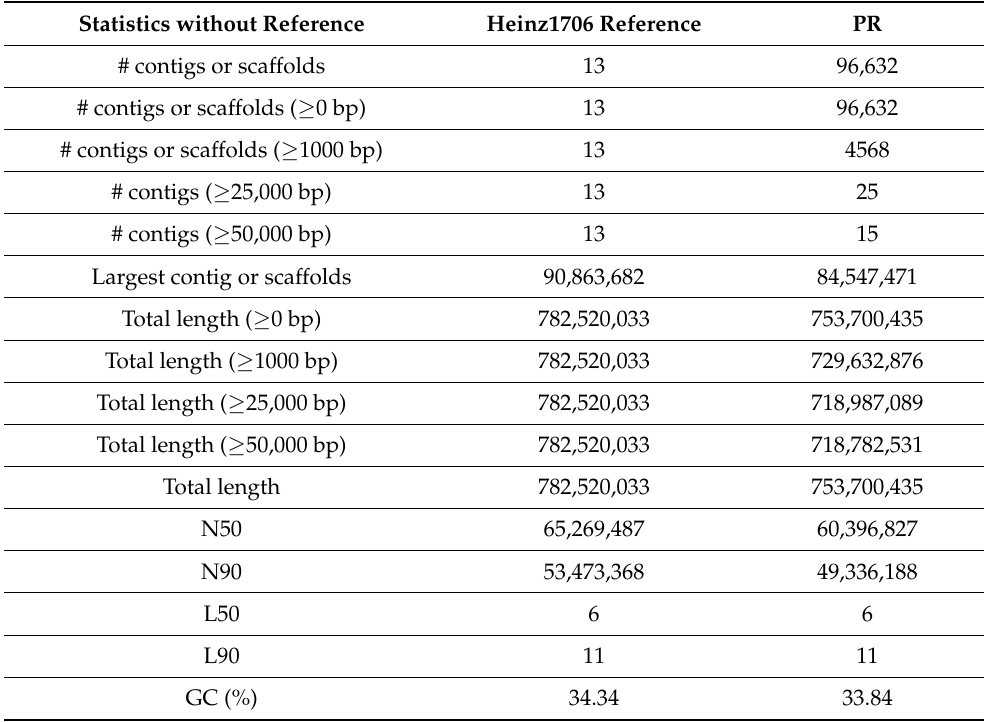
Table 2. QUAST statistics for the S. lycopersicum var. Heinz1706 reference genome and the S. lycopersicum cv. Pusa Ruby assembly by ragtag [38]. # -